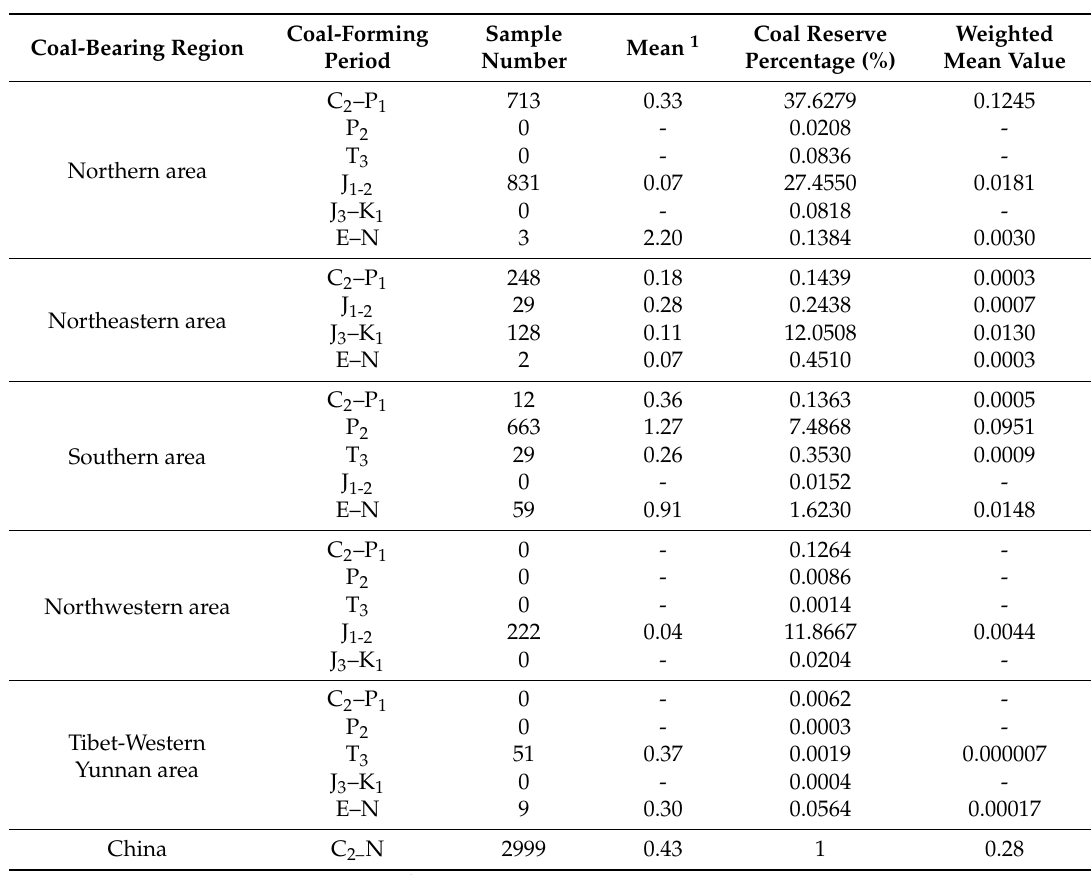
Table 4. The weighted averaging content in Chinese coals (unit: µ